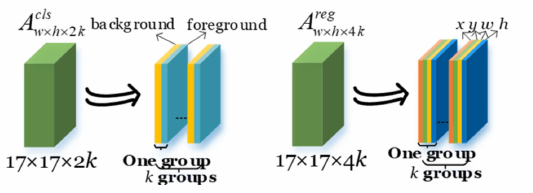
Figure 3. The feature composition of A cls